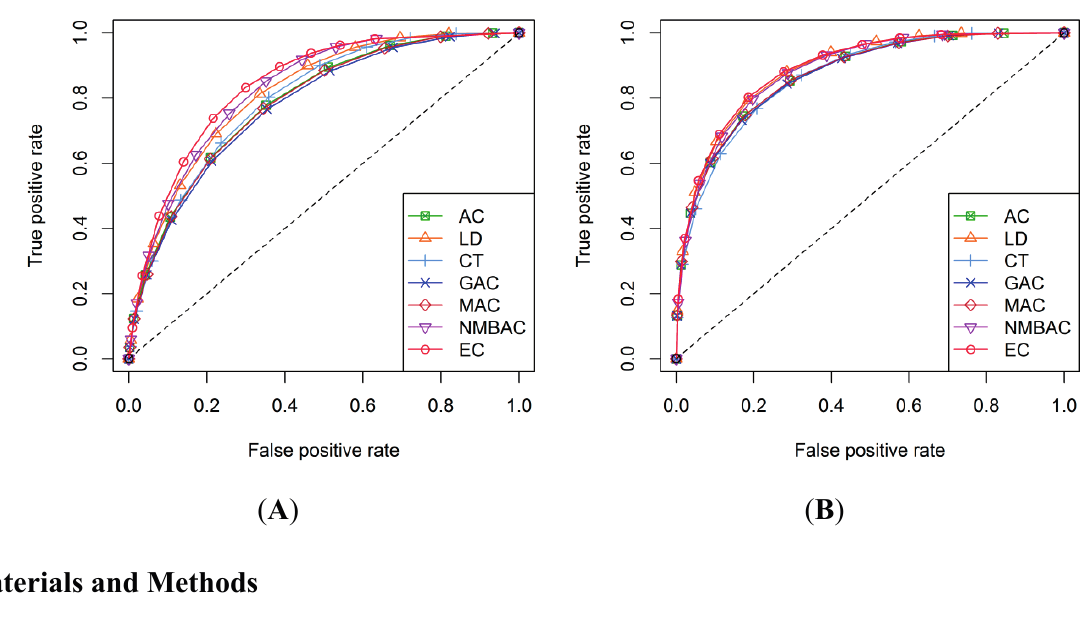
Figure 20. ROC curves of seven methods on the Human All dataset. ( A ) Gold Human model and ( B ) Silver Human